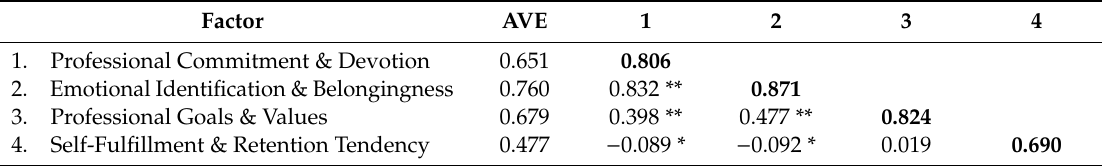
Table 6. Average variance extracted (AVE), square root of AVE ( between